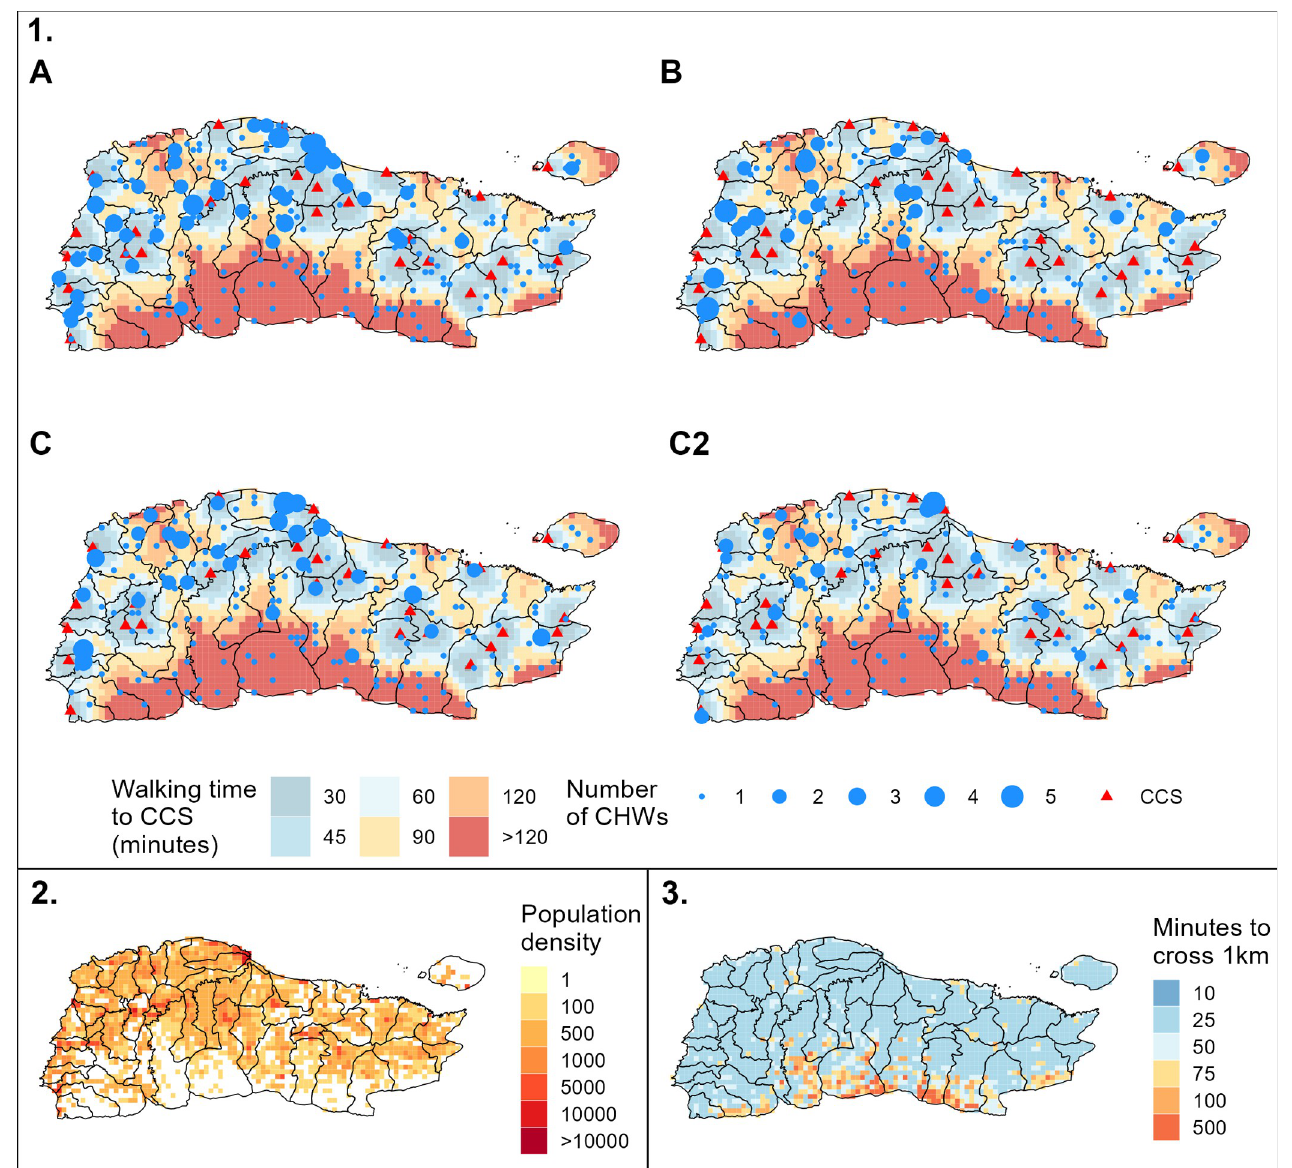
Fig 2. Comparison of the placement scenarios in the Grande-Anse department. 1. The four CHW placement scenarios (A, B, C and C2). CHW positions are indicated with blue dots, community health centres (CCS) are indicated with red triangles. The colored surface indicates the predicted walking time to the closest CCS using the methodology by Weiss and colleagues [23, 24]: difficult-to-reach areas, located more than 60 minutes walk from the nearest CCS, are shown in orange/red and areas with easier access (less than 60 minutes walk) are shown in blue. 2. For interpretability: prediction of population density in 2020 per square kilometre [27, 29]. 3. For interpretability: walking time friction surface by Weiss et al. is shown as the time required to cross 1km [23]. The shapefile from the Centre National de l’Information Ge´o-Spatiale (CNIGS) was used [30] (available at https://data.humdata.org/dataset/hti-polbndl-adm1-cnigs-zip).